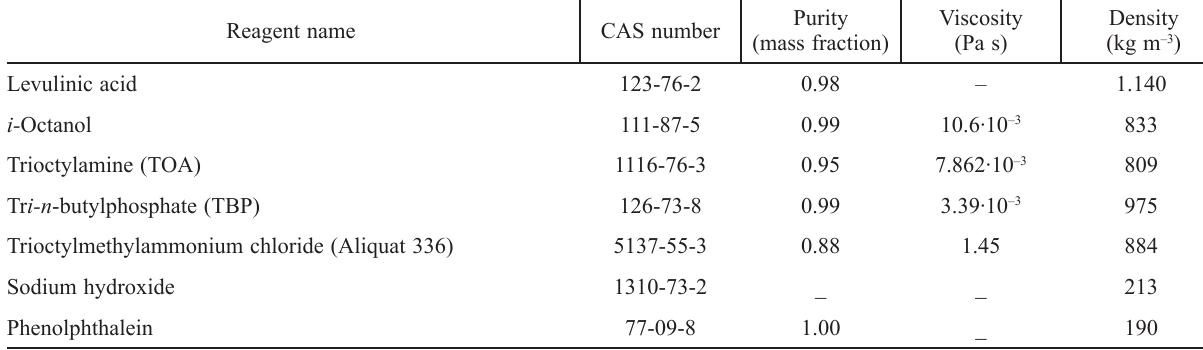
Table 1 – List of various chemicals and solvents used in the